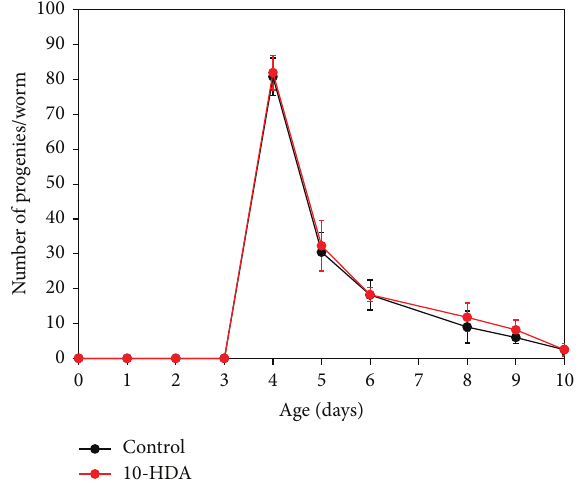
Figure 4: The effect of 10-HDA on the progeny production of wild type C. elegans . The progeny production is plotted against age at transfer. Mean values and SD are shown ( 𝑛 = 6 ). Day 0 corresponds to the hatched L1